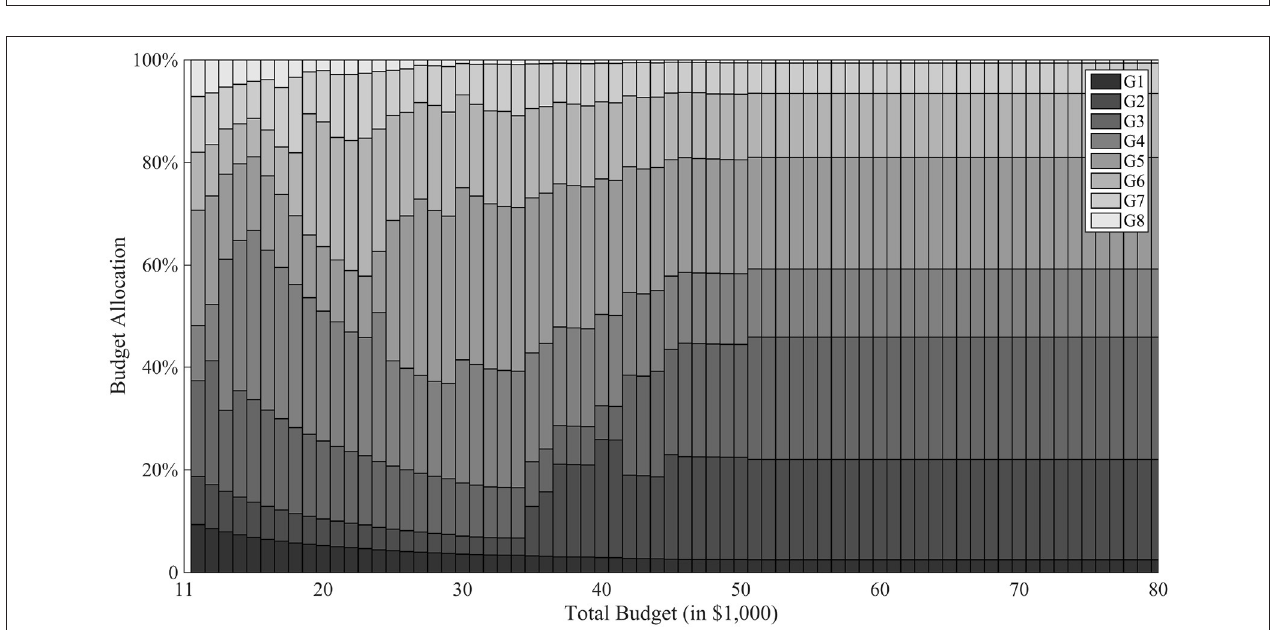
FIGURE 6 | Budget allocation with T = 8. In the figure, the horizontal axis is different total budget scenarios of the breeding project and the vertical axis represents the proportion of budget allocated in different generations. Different gray scale are used for different generations.